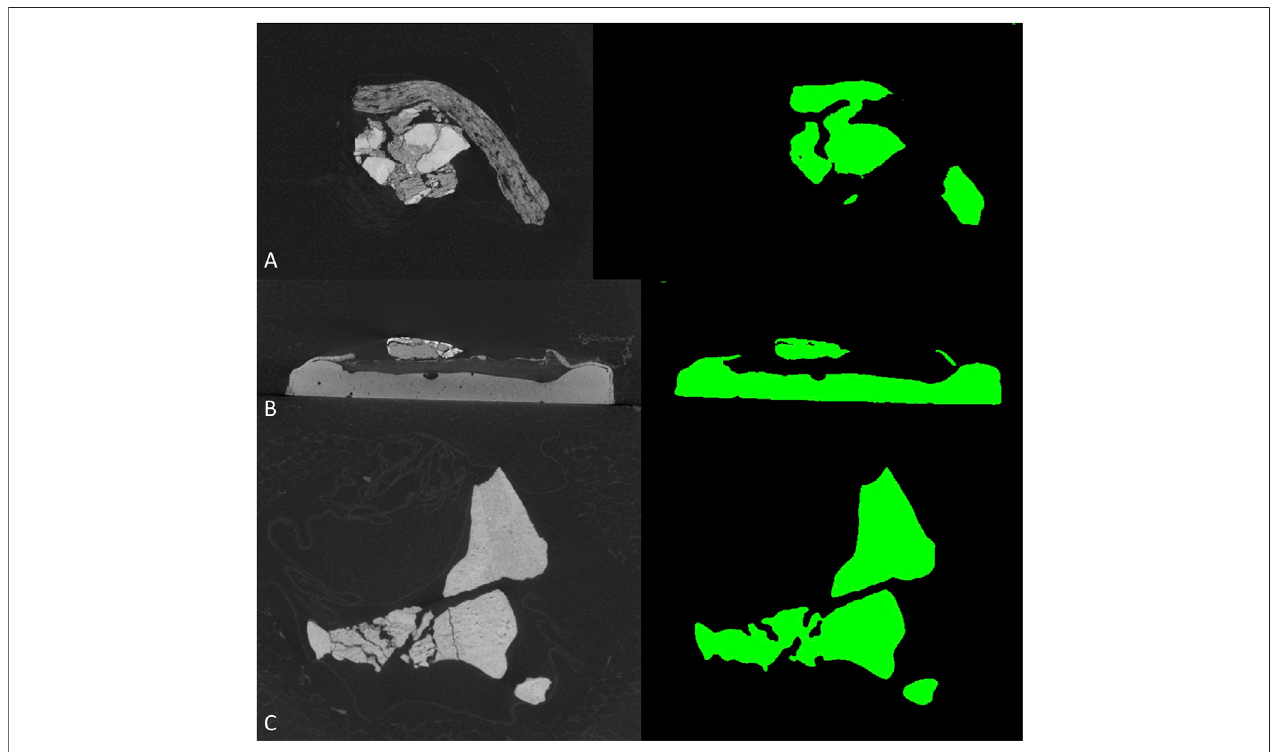
FIGURE6| Segmentationresultsofnon-protoceratopsiandinosaursbyDeepLabv3+withMobileNetv1asfeatureextractor. (A) . Haya ,IGM100/3178; (B) . Haya , IGM 100/3181; (C) . Pinacosaurus , IGM 100/3186.